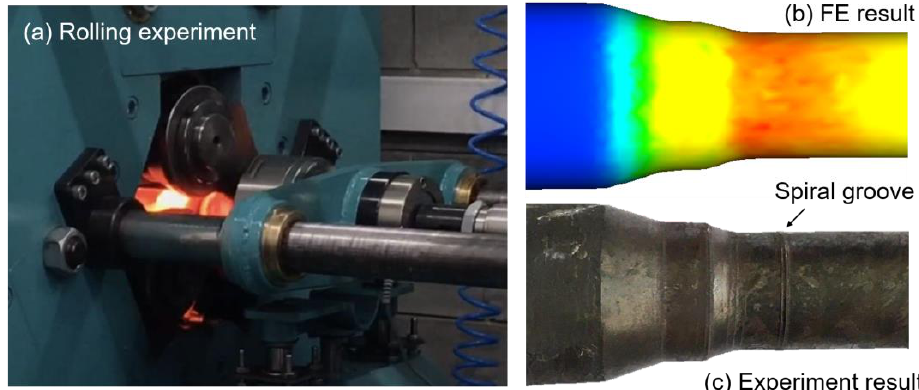
Figure 2. Comparison of FE and experiment results.